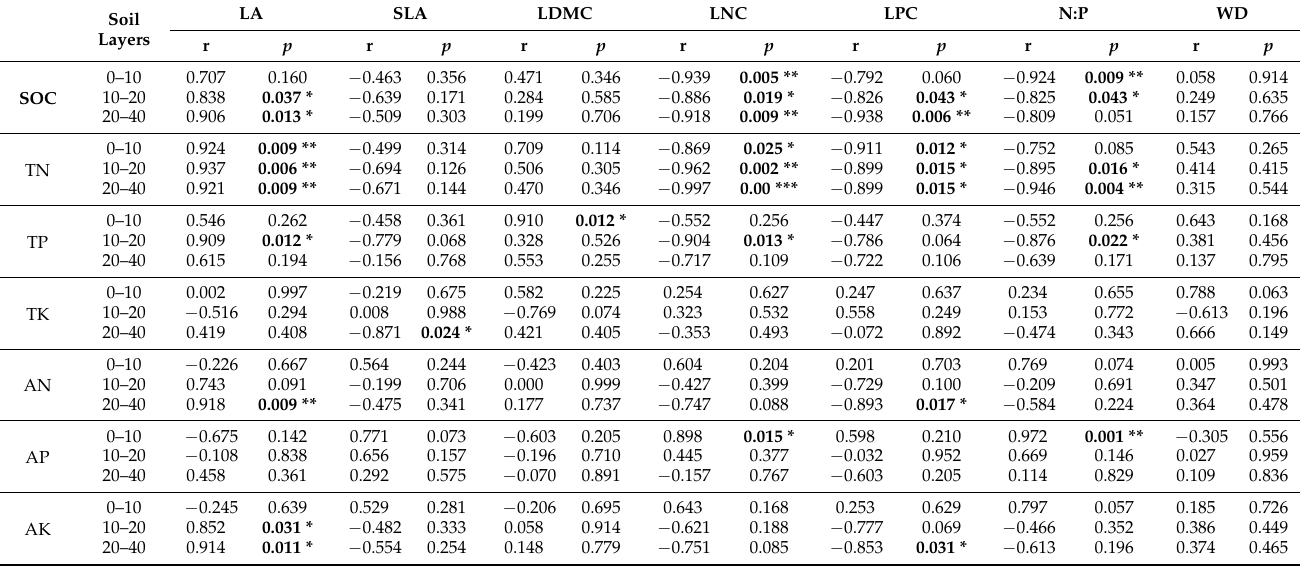
Table 2. Correlations between leaf traits, wood density (WD), and soil nutrients in moso bamboo. Soil